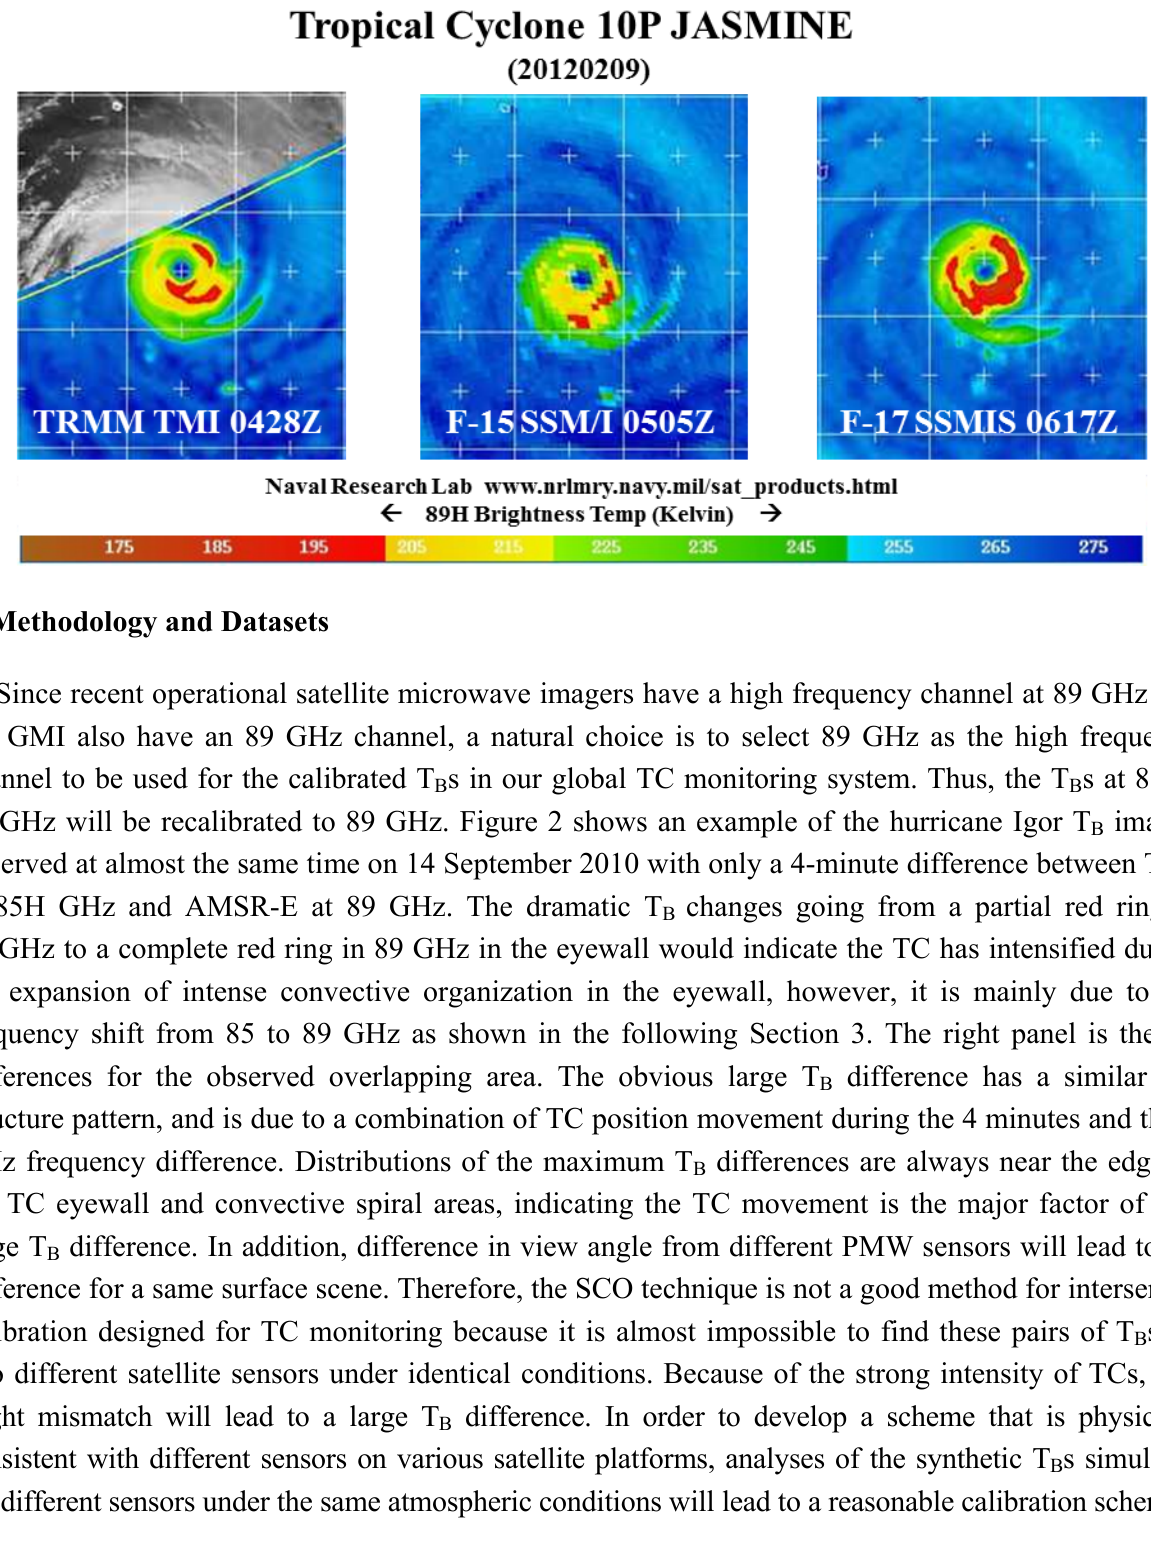
Figure 1. H-polarization high frequency image comparison of Tropical Rainfall Measuring Mission (TRMM) microwave imager (TMI), Special Sensor Microwave/Imager (SSM/I), and Special Sensor Microwave Imager Sounder (SSMIS) for tropical cyclone Jasmine